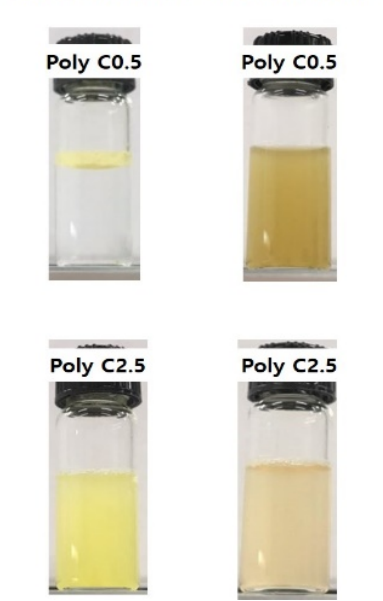
Figure 5. Photographs showing the dispersibility change of FPP (Poly C0.5) and FPF (Poly C2.5) upon exposure to H 2 O 2 .